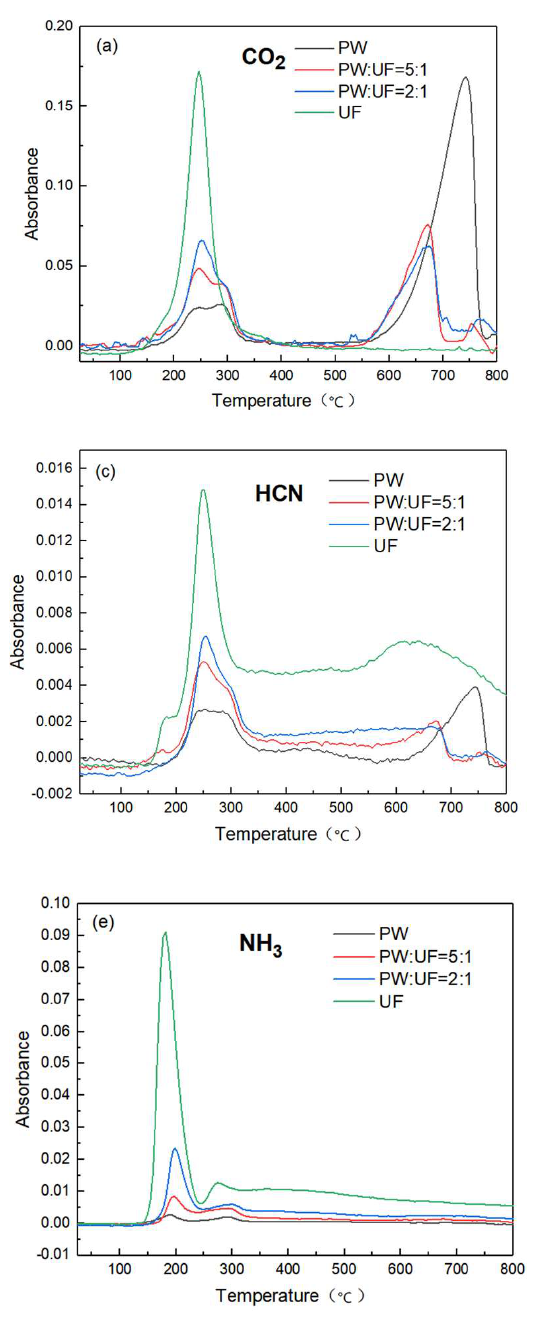
Figure 5. The evolution characteristics of main gas products as a function of the temperature. ( a ) CO 2 ; ( b ) CH 4 ; ( c ) HCN; ( d ) HNCO; ( e ) NH 3 ; ( f ) NO.